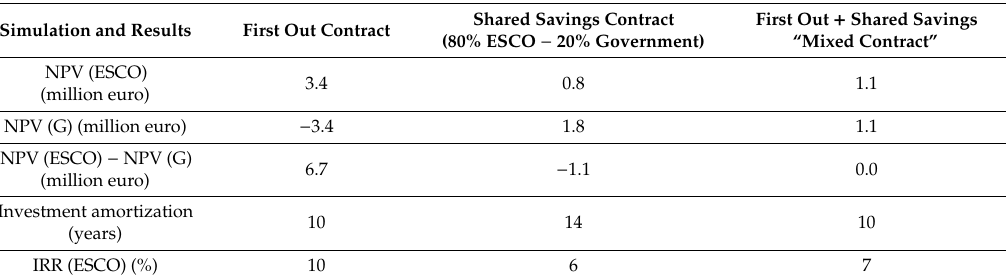
Table 3. Net present value comparison in EPC